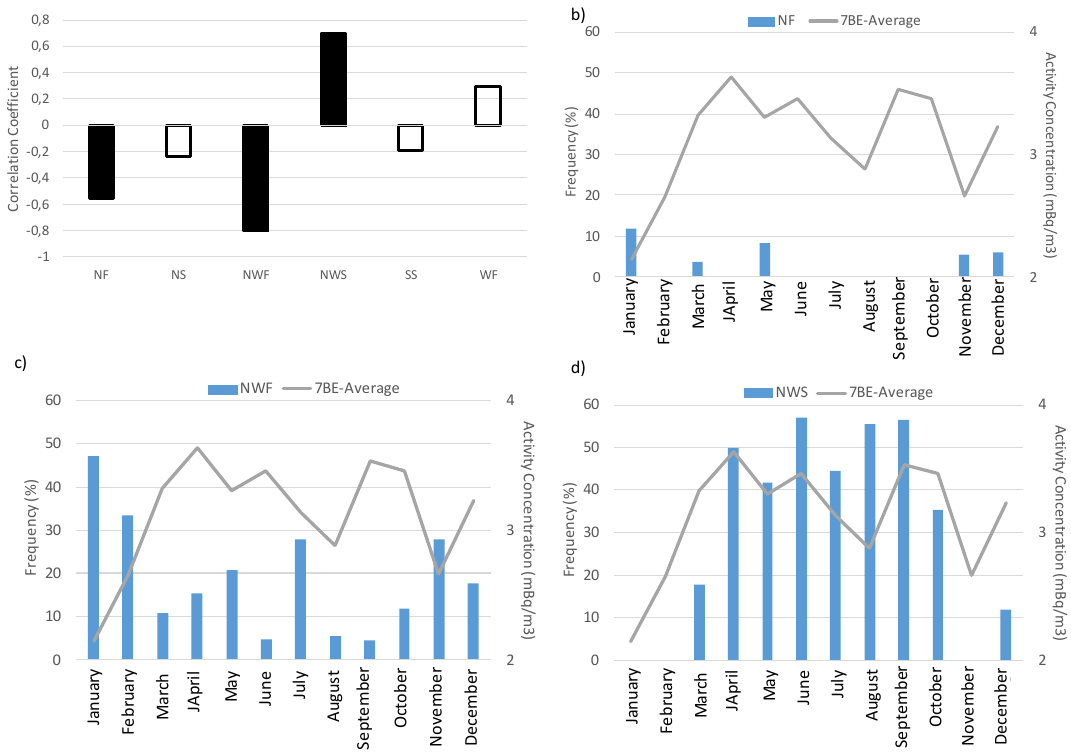
Figure 11. ( a ) Correlation coe ffi cients of the monthly 7 Be activities and airflow patterns (Only correlation coe ffi cients with a p -value < 0.05 are highlighted in the figure), and monthly specific activities for 7 Be and their relationship to the monthly frequency of ( b ) NF, ( c ) NWF, and ( d ) NWS flows. Only persistent sampling periods are used.